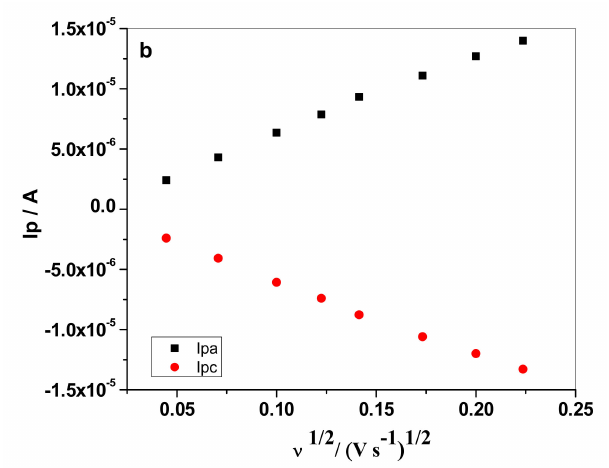
Figure 4. Cyclic voltammograms recorded with HP-AuNPs electrode in the presence of 1.0 mM K 4 [Fe(CN) 6 ] + 0.2 M KCl, at di ff erent scanning rates, from 2 to 100 mVs − 1 (2, 5, 10, 15, 20, 30, 40, 50, 100 mVs − 1 ) ( a ). The linear plots obtained between anodic / cathodic peak current (I p ) and the square root of scan rate (v 1 / 2 ) ( b ).